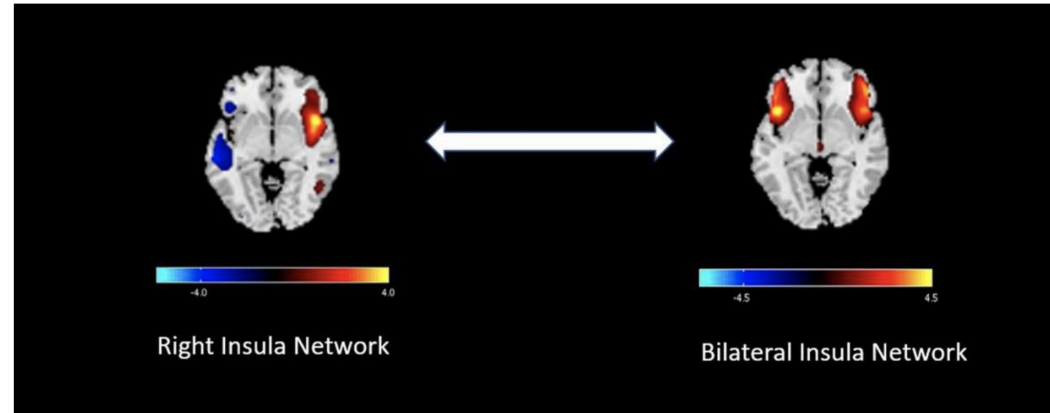
Figure 1. Central e ff ect. The fMRI brain images (see bidirectional arrow) depicting a component containing maximal values in the right insula extending into left temporal lobe described as right insula network and a component containing right and left insula described as bilateral insula network that were compared after exposure to a nausea-inducing visual stimulus in 10 gastroparetics and 8 healthy controls. The functional network connectivity was significantly reduced ( p < 0.001) in gastroparetic patients versus healthy controls after visual stimulation between the right insula network and bilateral insula network. The highlighted areas illustrate the locations of reduced connectivity in gastroparesis